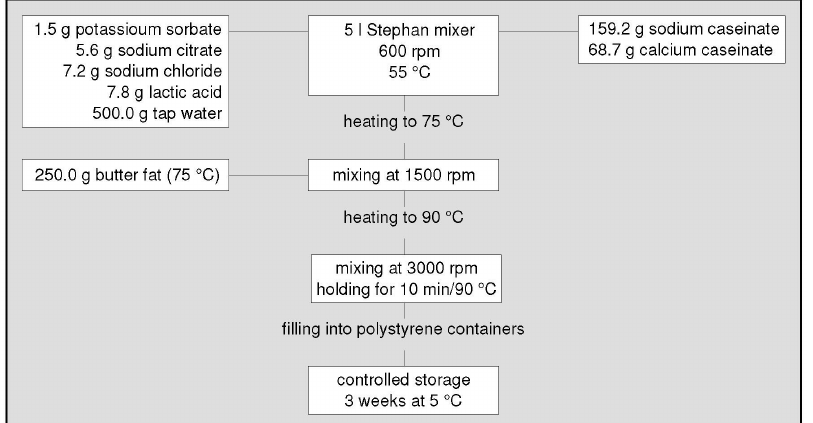
Fig. 1: Flow scheme for processed model cheese